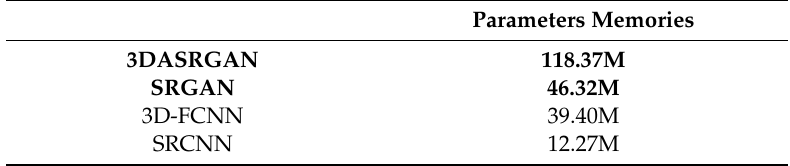
Table 4. The occupied memories of different SR methods on the Washington DC Mall dataset.